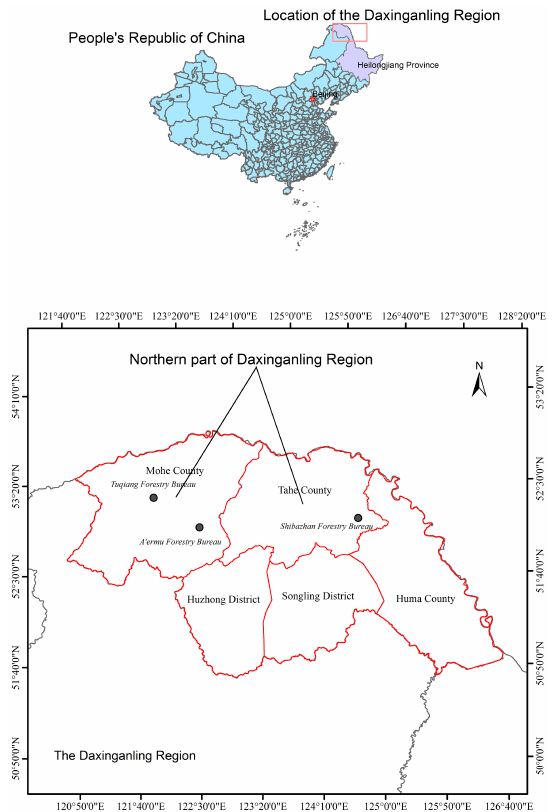
Figure 1. Location of the northern part of the Daxinganling Region.